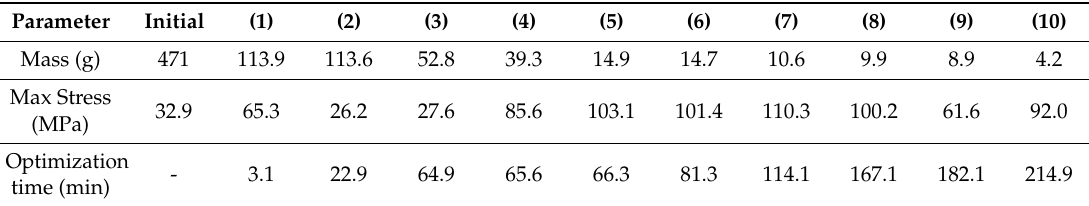
Figure 17. The design results of the MBB-Beam. Table 7. The results of all design processes of the MBB-Beam